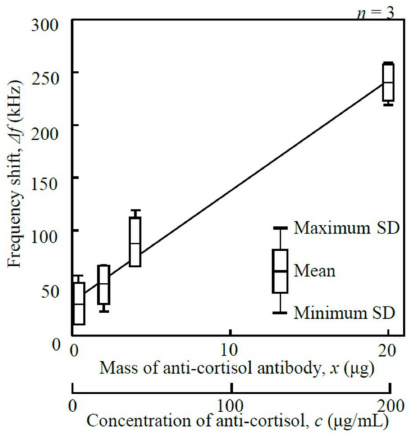
Figure 7. Relationship between the frequency shift, ∆ f , and the mass of anti-cortisol antibody, x (1.402 MHz measured